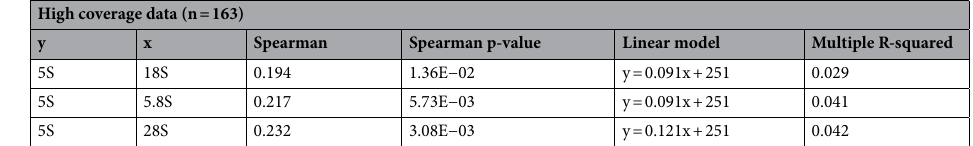
Table 3. Correlations between 45S and 5S rDNA copy numbers in the subset of high-coverage 1000 Genomes Project data also analyzed in the low-coverage dataset. The Spearman correlation coefficient and linear models that describe the relationships between the 45S and 5S rDNA copy numbers are shown.